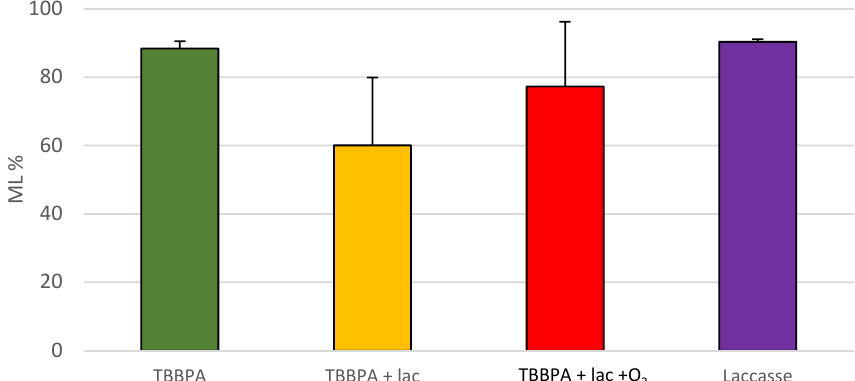
Figure 4. Mass loss percentage after 3 times in flame for 8 s. Control: water impregnated only; TBBPA: treated with TBBPA alone; TBBPA/Laccase: treated with TBBPA and laccase; TBBA/Laccase/O 2 : treated with Laccase and O 2 ; Laccase: treated with laccase alone. The bars represent the deviation